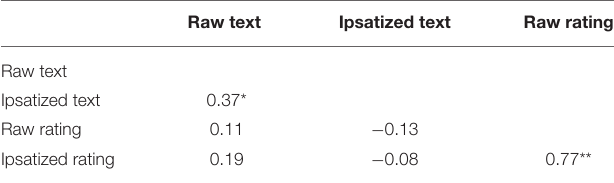
TABLE 12 | Overall similarity of the correlation matrices (using Mantel